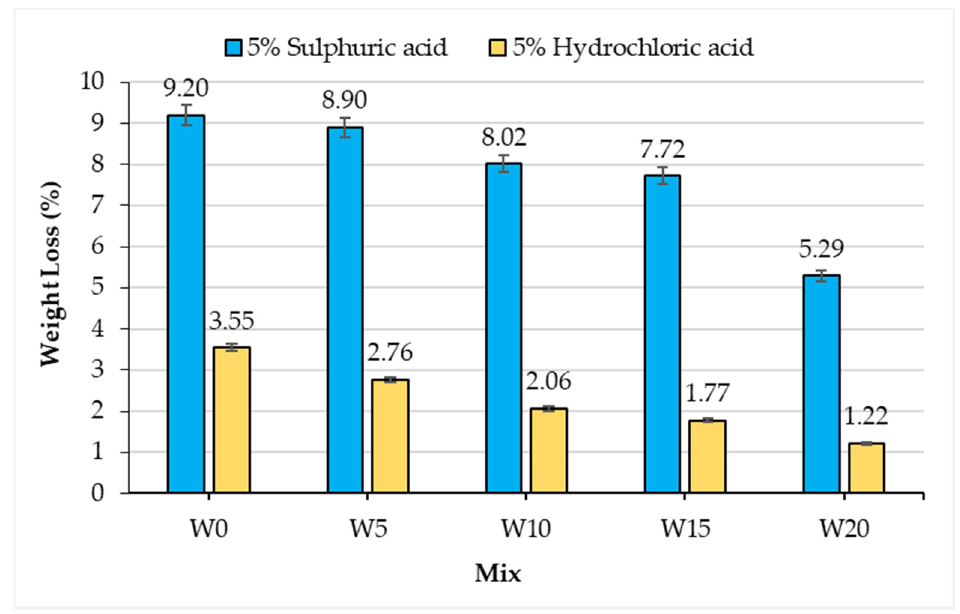
Figure 16. Deterioration of concrete mixes in terms of weight loss after exposure to the acid solu- tion.